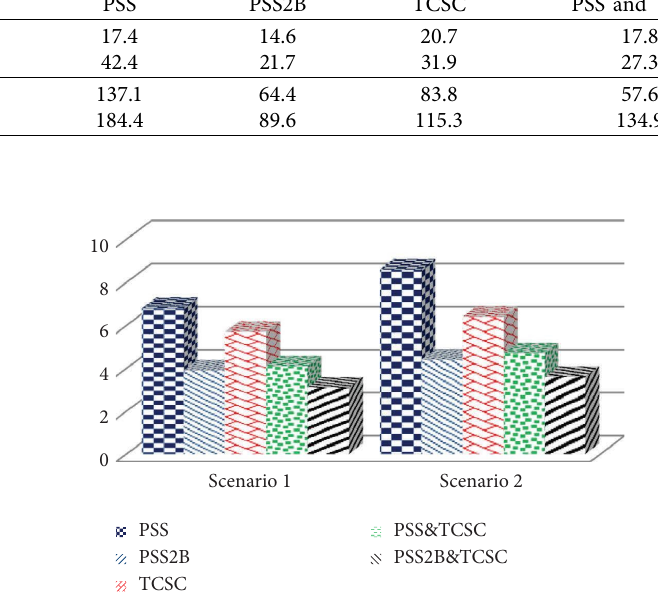
Figure 19: Damping time of oscillations.